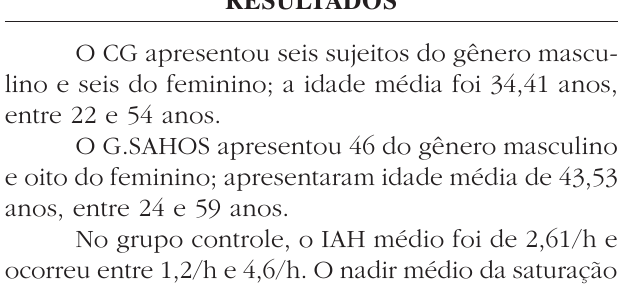
Teste exato de Fisher: p =0,027